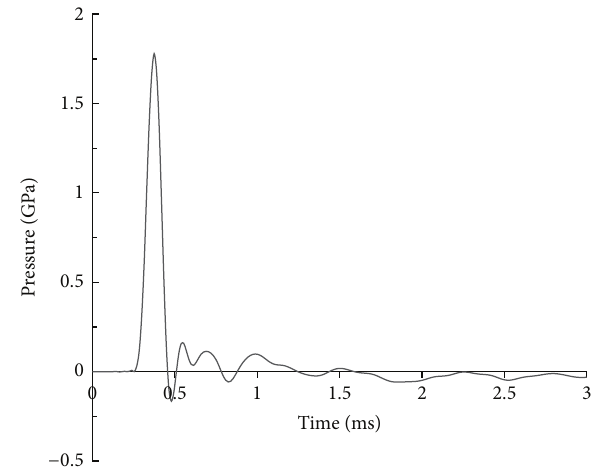
Figure 4: Pressure time history of Element H54050.